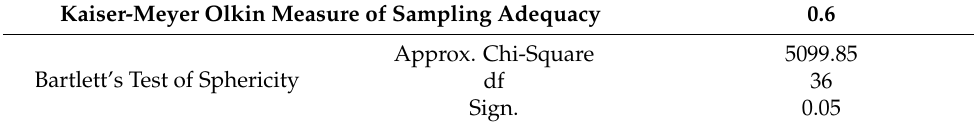
Table 4. KMO and Bartlett’s Test.